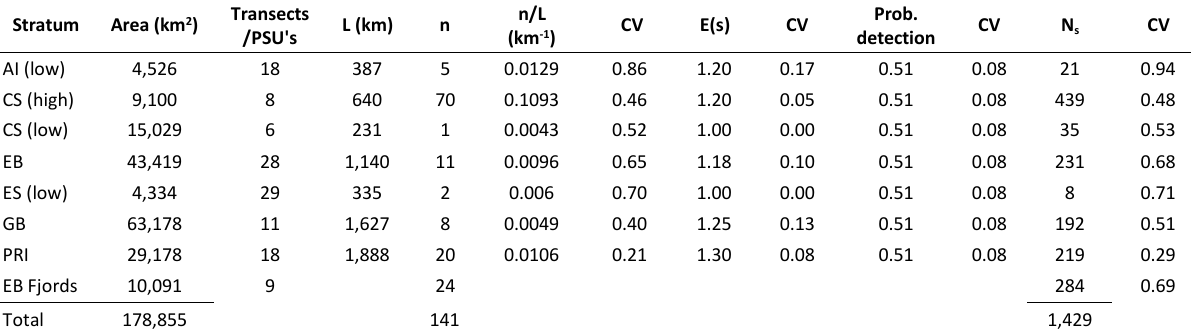
Figure 6. Group sizes of 117 unique sightings of bowhead whales in non- fjord strata. Table 1. Survey coverage, sightings, and abundance estimates of bowhead whales by stratum. L – transect length; n/L – encounter rate; E(s) – expected group size; N s – surface abundance, corrected for perception bias but not for availability. Only strata with bowhead sightings are shown. AI: Admiralty Inlet. CS: Cumberland Sound. EB: East Baffin. ES: Eclipse Sound. GB: Gulf of Boothia. PRI: Prince Regent Island. Low/high refer to sub-strata of low or high density